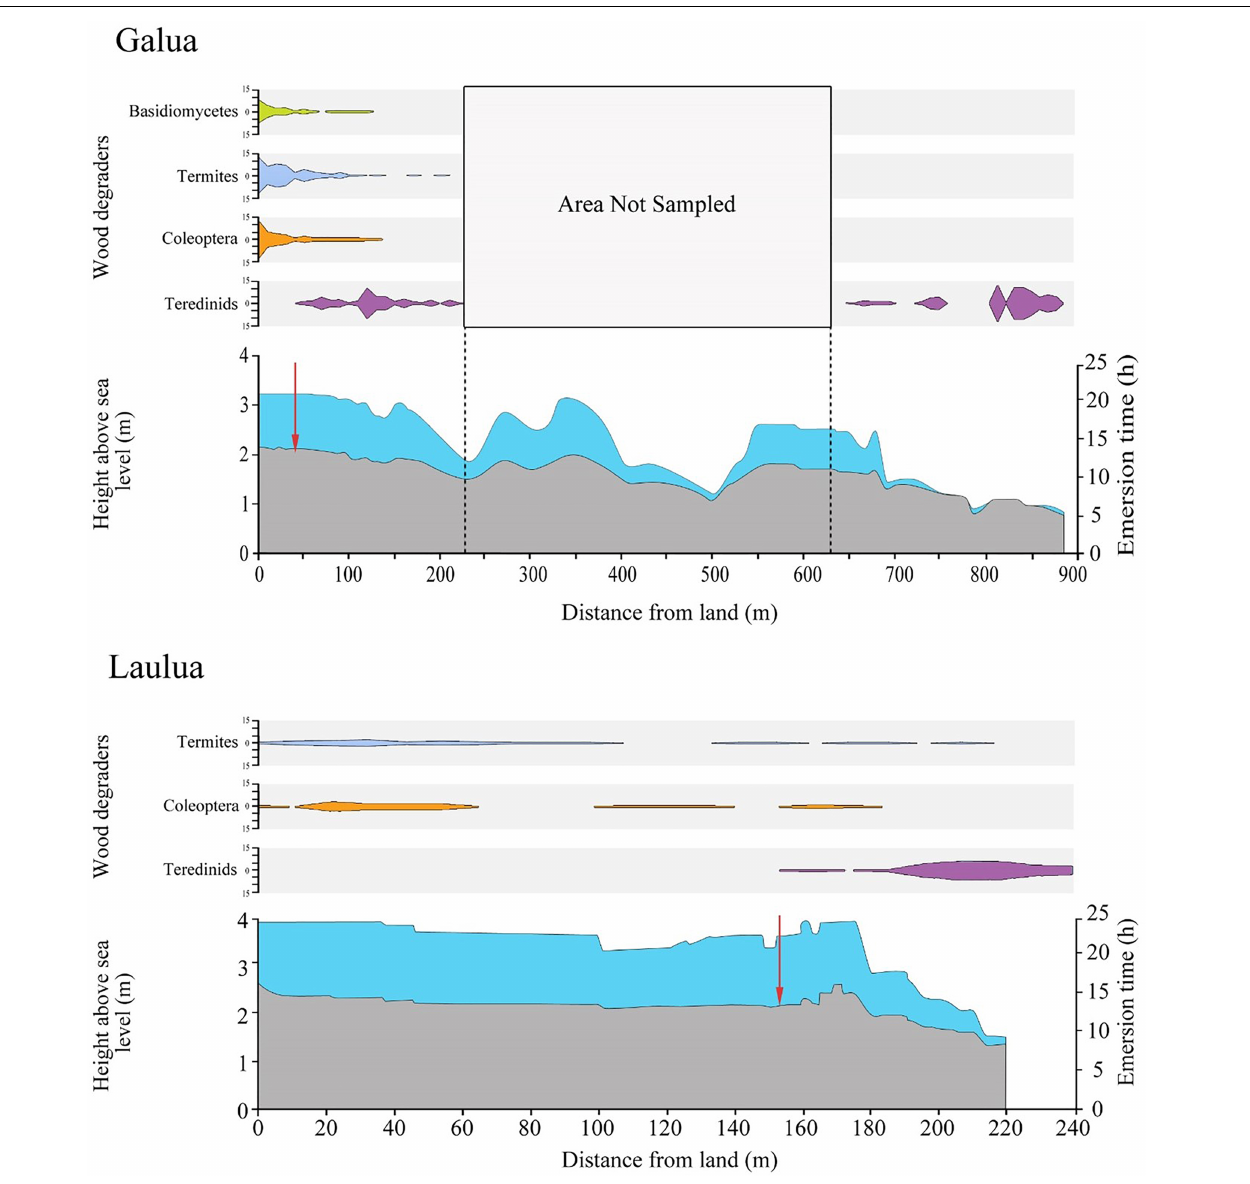
FIGURE 5 | Elevation and wood-degrading guilds within Galua and Laulua mangrove forests. Scale bars for wood degrading guilds represent total abundance of LWD items found containing that guild. Red arrows represent biodegradation boundary between terrestrial and marine wood-degraders. LWD items with no visible degradation were not plotted, and the area between 220 and 600 m in Galua was not sampled. Strandline on x -axis = 0 m. Note, x -axes